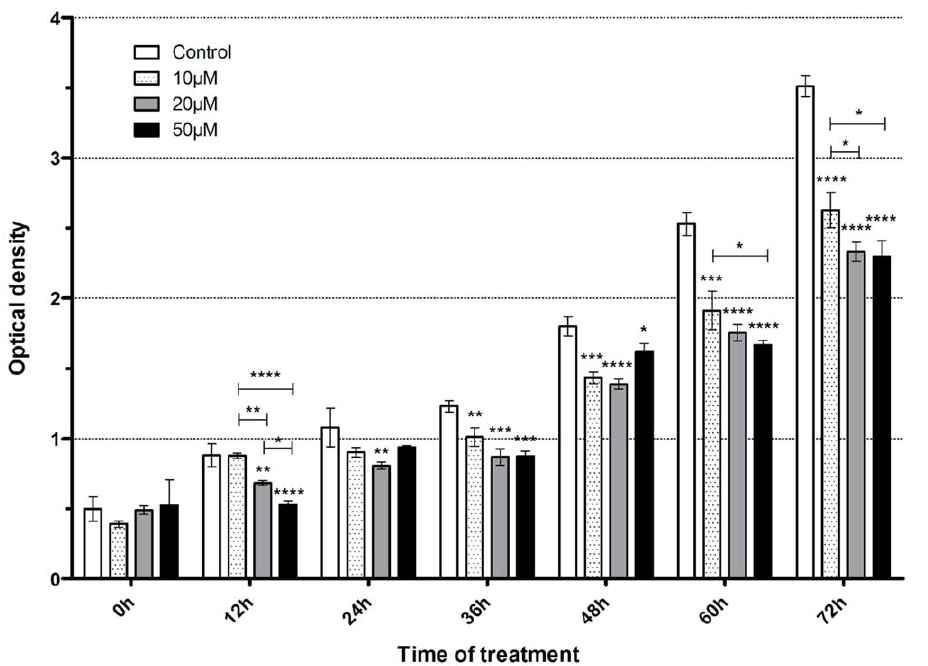
Figure 9. Evaluation of the expansion of viable HeLa cells with WST-1 assays. Cells were treated with different doses of Max* (hatched bars, 10 m M; grey bars, 20 m M and black bars 50 m M) for a period up to 72 hours before the WST-1 assay. Note the dose and time dependent reduction of expansion compared to the control (white bar). *, p , 0.05; **, p , 0.001; ***, p , 0.0001; ****, p , 0.00001.